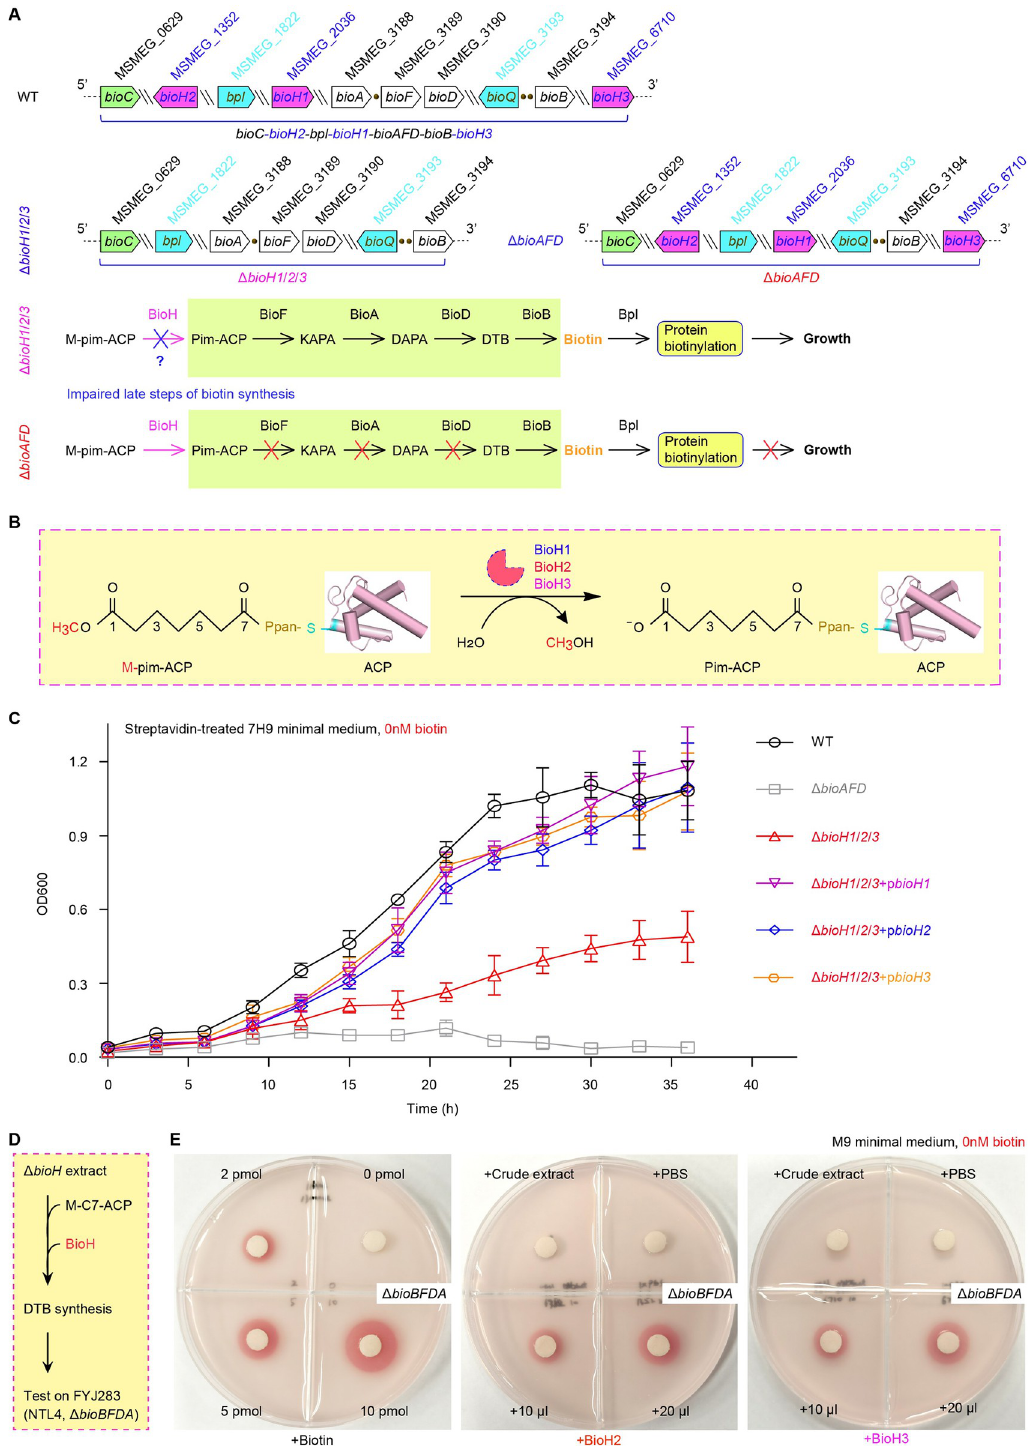
Fig 8. Genetic and biochemical evidence that three BioH isoenzymes are dedicated to biotin synthesis. A. Schematic illustration for genetic context of the triple bioH mutant ( Δ bioH1 / 2 / 3 )of M . smegmatis , a biotin auxotrophic strain. B. Chemical reaction for the three BioH isoforms that cleave the M-pim-ACP to produce pim-ACP. C. An individual bioH gene ( bioH1 to bioH3 ) can significantly restore the viability of the triple mutant of Δ bioH1 / 2 / 3 on the biotin-deficient growth condition. The MC2 155 strain (WT) is the positive control, and the biotin auxotrophic strain of M . smegmatis ( Δ bioAFD ) lacking the late step